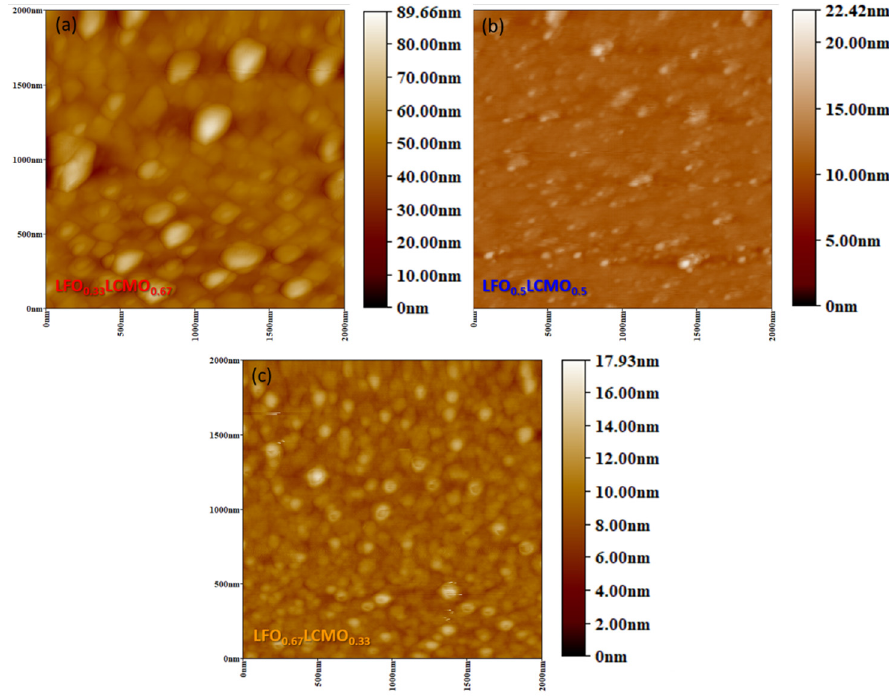
Figure 2. Atomic force microscopic images to show the surface morphology of ( a ) LFO 0.33 LCMO 0.67 , ( b ) LFO 0.5 LCMO 0.5 and ( c ) LFO 0.67 LCMO 0.33 composite thin films.